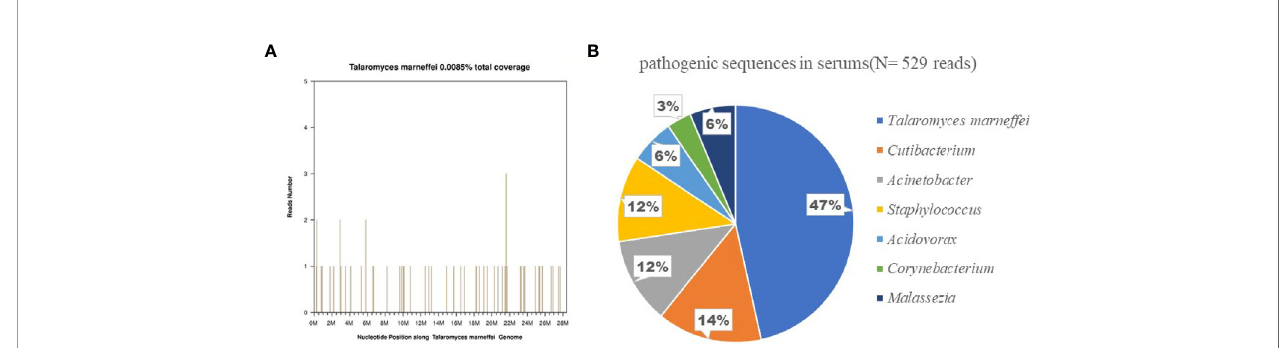
FIGURE 1 | Con fi rmation of talaromyces marneffei speci fi c ampli fi cation from plasma by next-generation sequencing. (A) shows the reads mapped to talaromyces marneffei derived from NGS data. A total of 248 reads mapped to talaromyces marneffei in the reference database which contains about 8000 pathogen genomes, and got a total coverage of 0.0085% respectively. (B) shows the distribution of bacterial sequences (N = 529 reads) identi fi ed in the patient ’ s plasma included Talaromyces marneffei (N = 248;47%), Cutibacterium, Acinetobacter, Staphylococcus, Acidovorax, Corynebacterium, Malassezia.